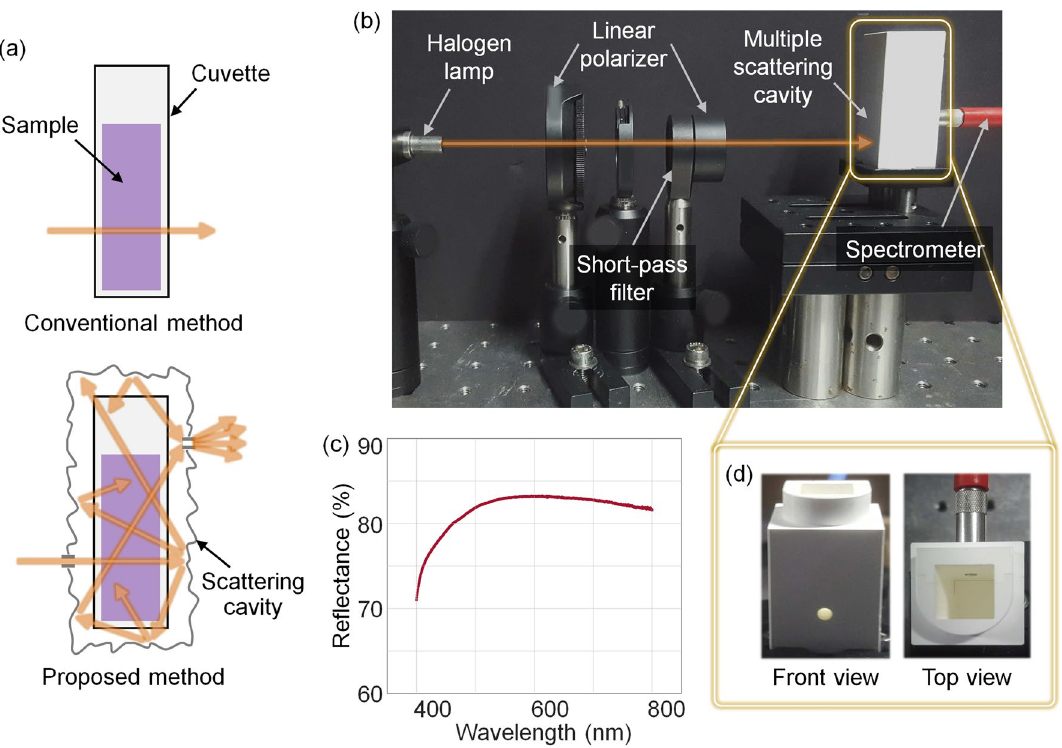
Figure 1. ( a ) Schematics of the conventional method and proposed method. ( b ) Photograph of the experimental setup. ( c ) Reflectance of h-BN. ( d ) Front (left) view and top (right) view of the scattering